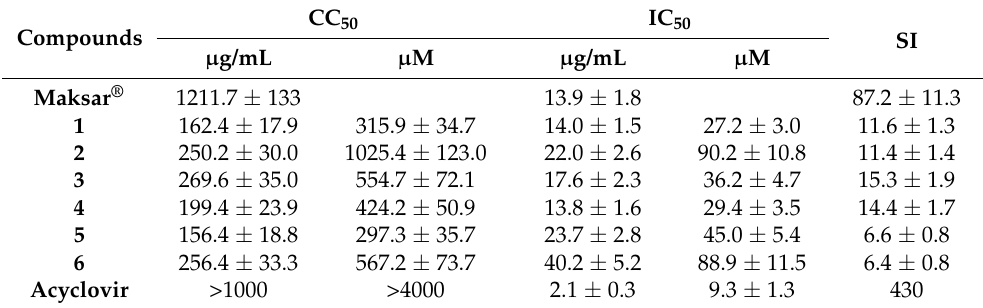
Table 4. Cytotoxicity and anti-HSV-1 activity of polyphenolic compounds from M. amurensis (CPE as-